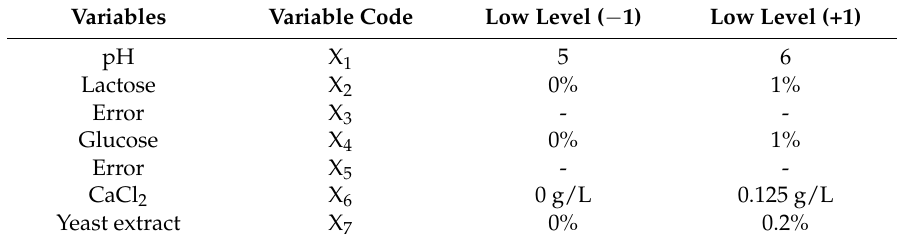
Table 1. Range of different variables studied in the Plackett–Burman design (PBD).